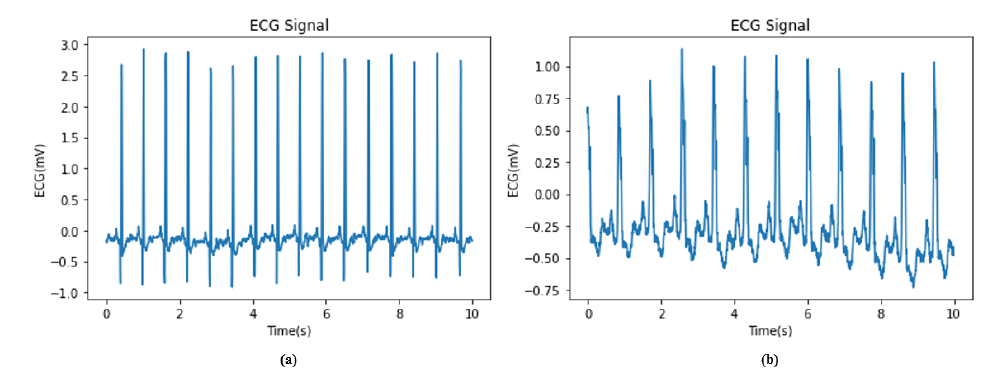
Figure 1. The raw ECG signals. ( a ) A healthy subject. ( b ) A HF patient. Table 2. The characteristics of the databases. Database Number of Signals Properties MIT-BIH